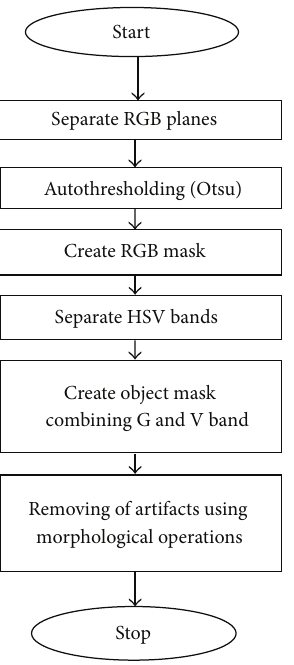
Figure 2: Flowchart for